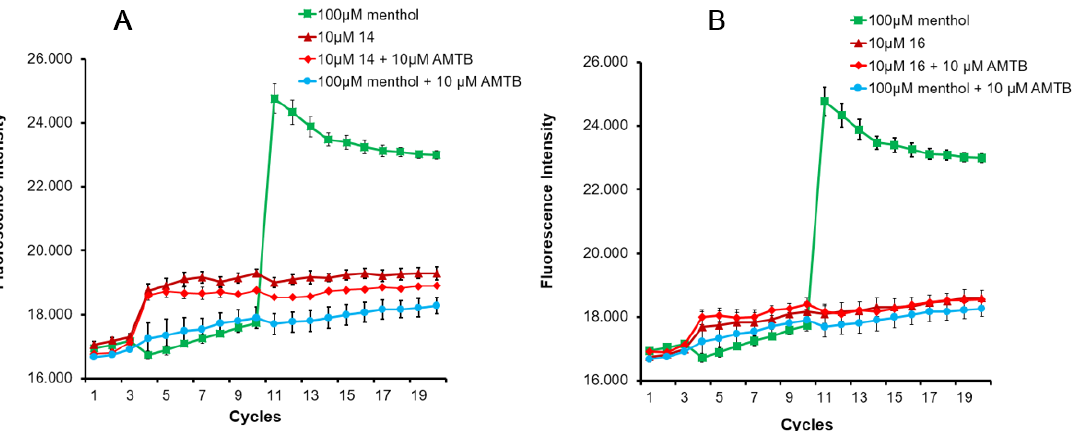
Figure A1. Effect of compounds on TRPM8 activity measured by fluorometric methods. Representative graph of compound 14 ( A ) and 16 ( B ) at 10 μ M on HEK-rTRPM8 cells. After 3 basal fluorescence measurements compounds 14 ( A ) and 16 ( B )